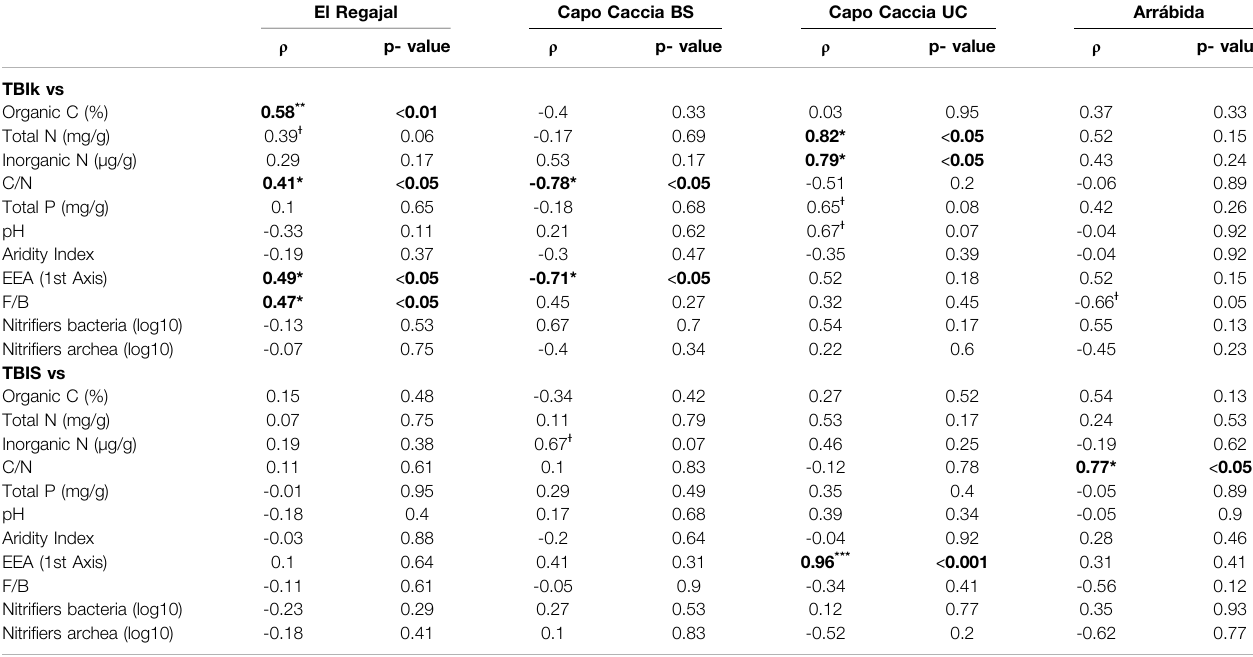
TABLE 6 | Results of the Spearman ’ s rho tests between the decomposition rate (TBIk) and stabilisation factor (TBIS) and the studied variables in El Regajal (Spain, n (cid:2) 24), Capo Caccia BS (Italy, n (cid:2) 8), Capo Caccia UC (Italy, n (cid:2) 8) and Arrábida (Portugal, n (cid:2) 9). Capo Caccia BS and Capo Caccia UC indicate bare soil and under canopy microsites. EEA and F/B stand for extracellular enzymatic activity and fungi to bacteria ratio, respectively. Statistical differences are indicated as * p < 0.05, ** p < 0.01, and *** p < 0.001andare highlighted inbold. Ɨ isusedtodesignate acorrelationwith p ≤ 0.1. Therhovalue( ρ )and thelevel ofsigni fi cance( p value)areshown for each correlation. El Regajal